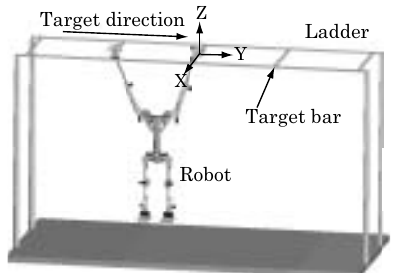
Figure 13 Measuring points. Figure 12 Coordinate system.